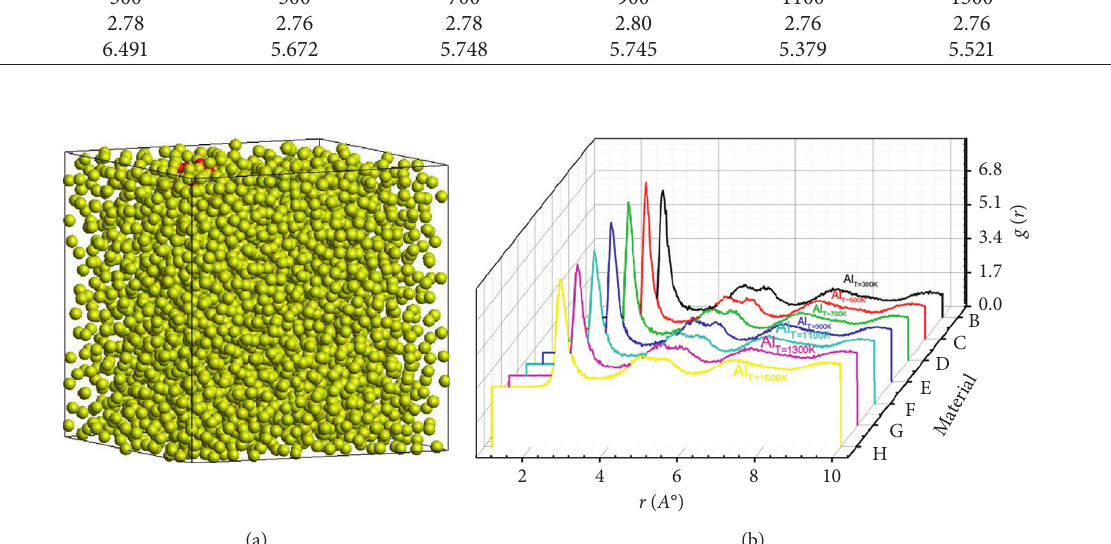
Figure 5: The radial distribution function of the bulk aluminium sample at different